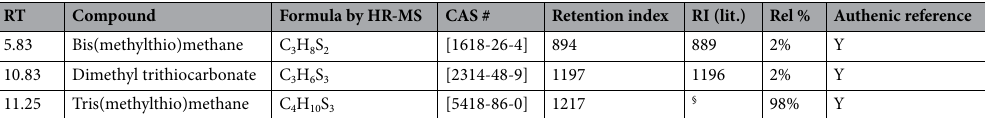
Table 1. Mass spectra and retention indices (RI) in comparison with authentic samples. § The RI given in the NIST MS database and by other authors as well as the mass spectrum of Tris(methylthio)methane published there and in the Wiley MS database are not correct. GC-MS of an authentic sample purchased from Aldrich revealed an RI of 1217 and a mass spectrum identical to the mass spectrum of the compound at the identical retention time from the headspace of M. hyalina